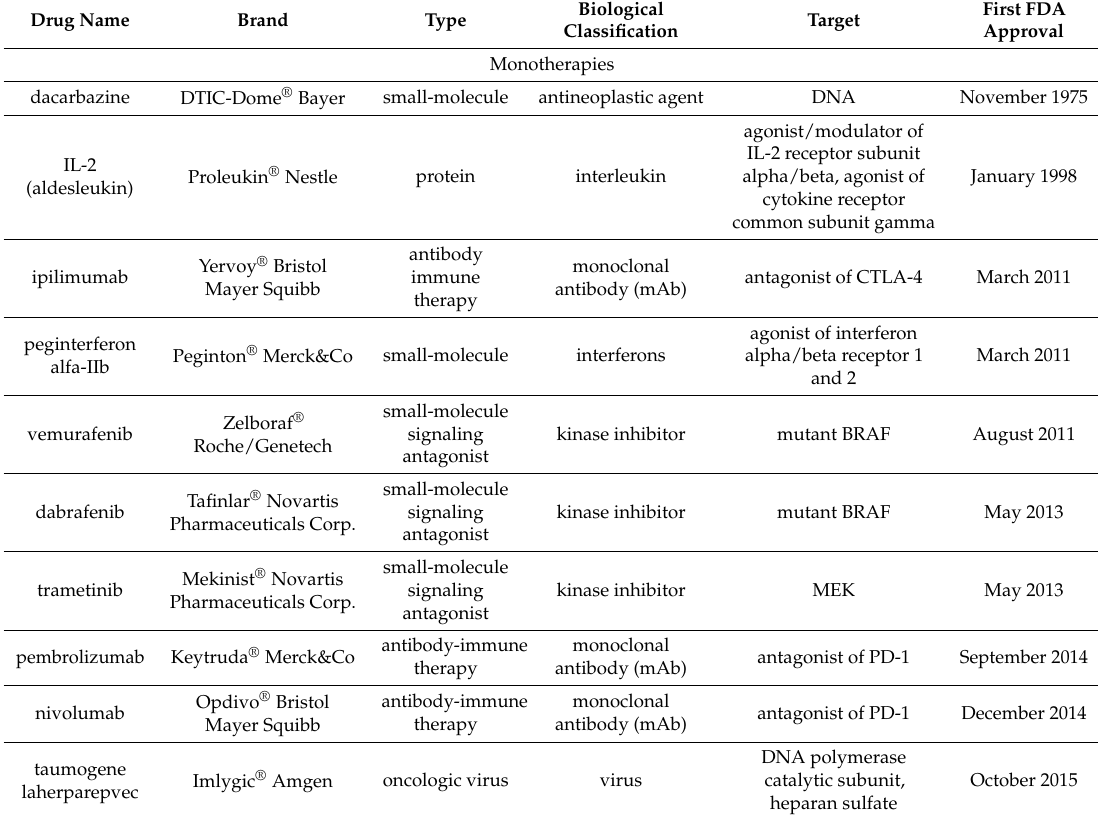
Table 1. FDA approved melanoma drugs [60,61].